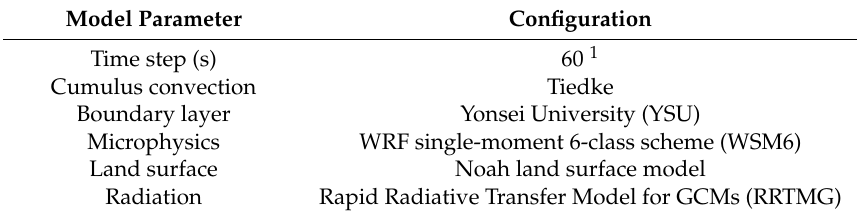
Table 1. Model configuration for Hurricane Sandy WRF 12-4 km, WRF 12 km and WRF 4 km